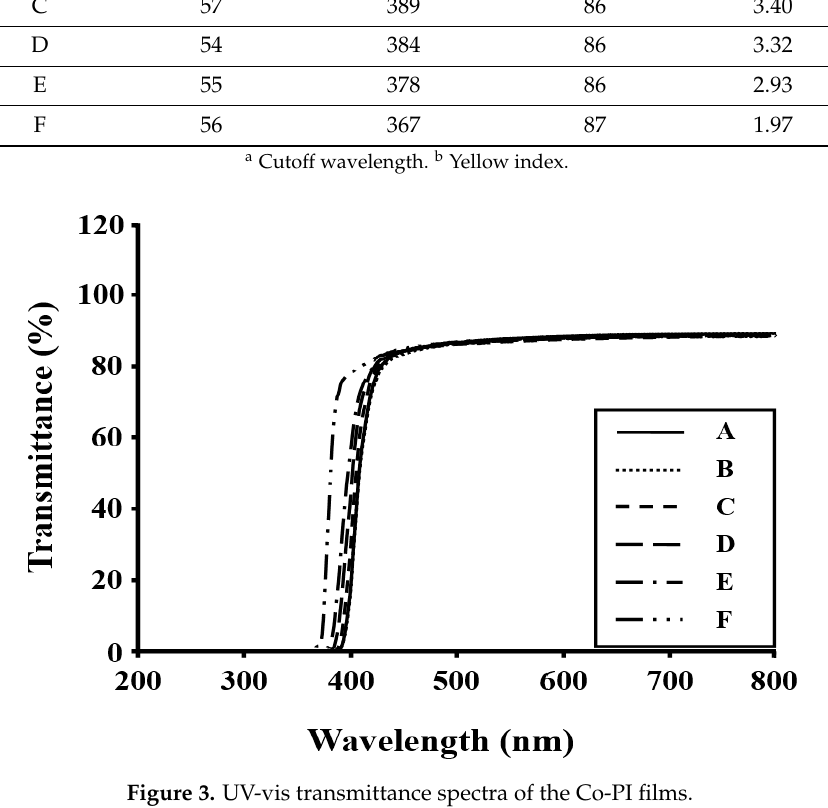
Figure 3. UV-vis transmittance spectra of the Co-PI films.